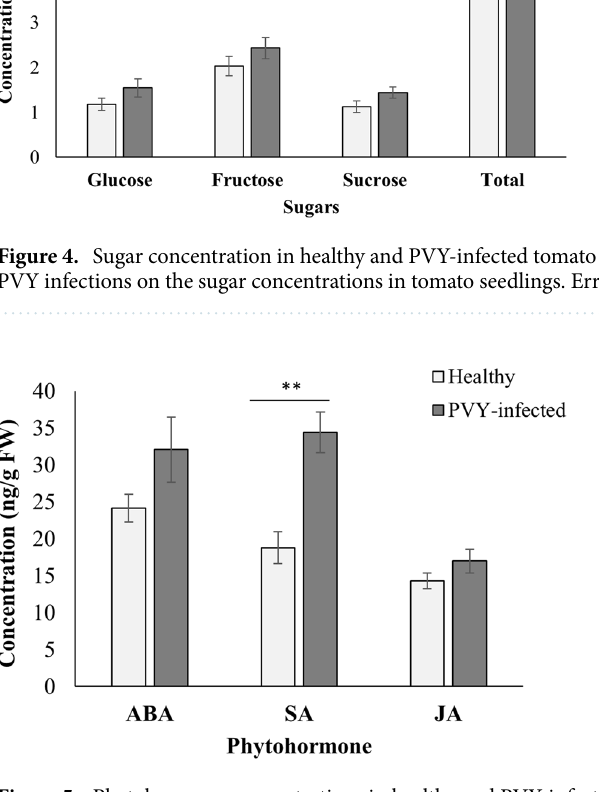
Figure 5. Phytohormone concentrations in healthy and PVY-infected tomato plants, with only SA showing a significant increase following PVY° infection; the significant difference is indicated by an asterisk ( P = 0.003). Error bars represent standard error (±